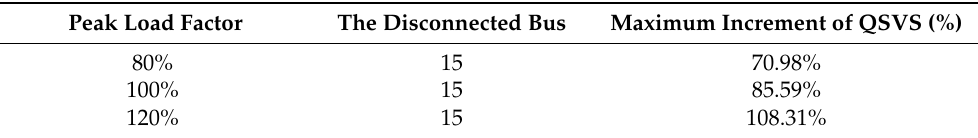
Figure 6. Variation of QSVS for load removal from each bus and for each peak load factor on IEEE 33-bus test distribution system. Table 4. The candidate location of a single RDG installation for each peak load factor of IEEE33-bus test distribution system using Algorithm 1.